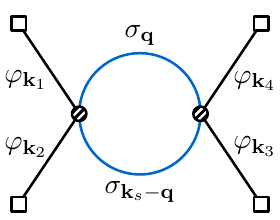
Figure 7 . The 4-point function mediated by a pair of massive scalars σ at 1-loop level. form of ϕ 0 χ . Then, by integrating out χ we get the desired effective coupling in (4.1). The resulting 1-loop process is shown in figure